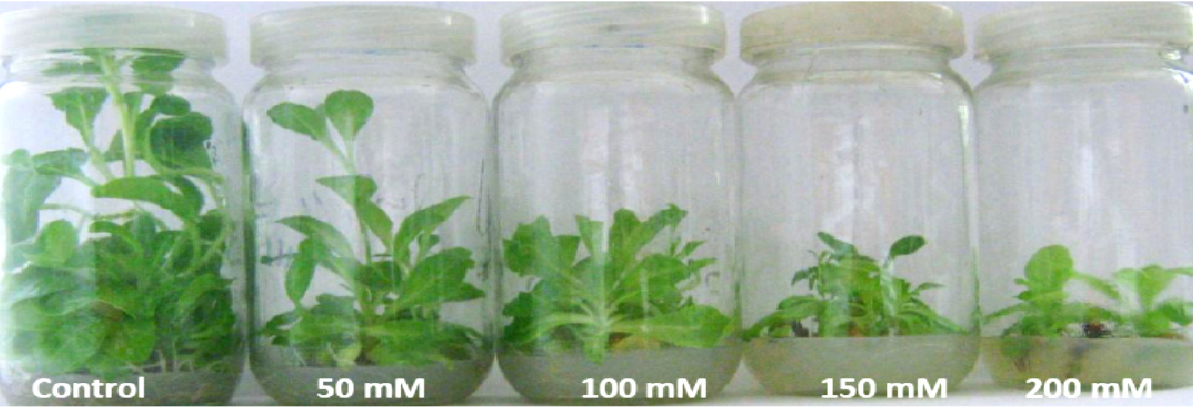
Fig. 2. Effect of NaCl concentrations on Nicotiana alata haploid plants survival in Nicotiana